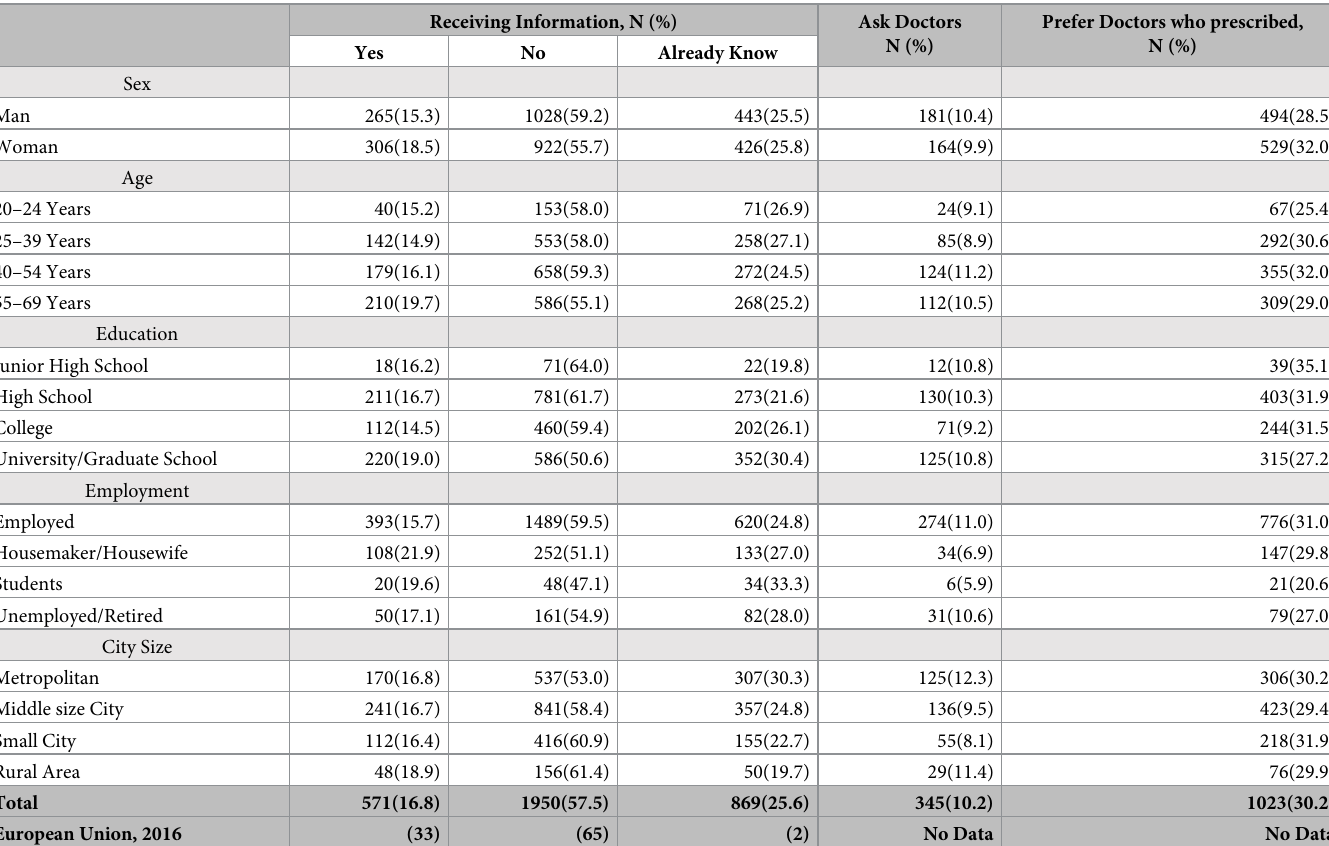
Table 6. Information receipt on antibiotics, behaviour and perception among